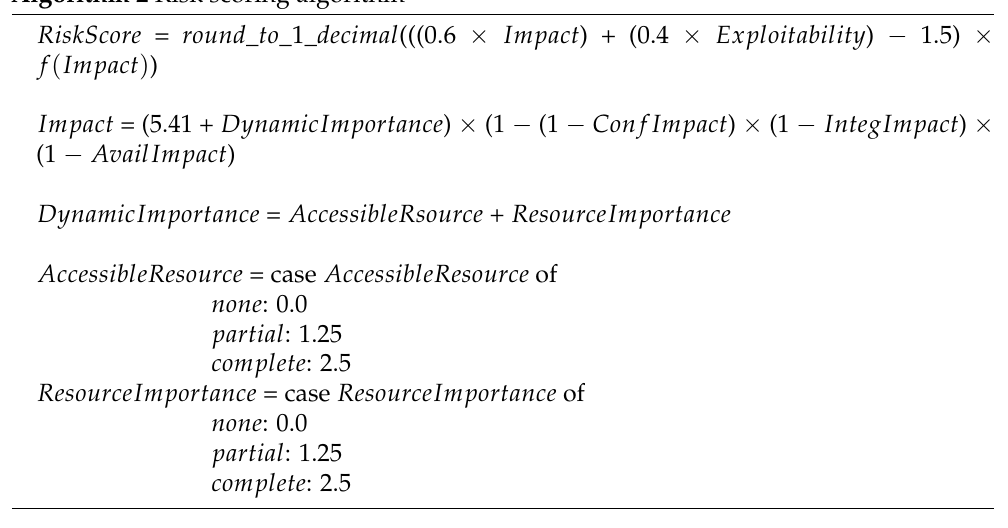
Algorithm 2 Risk scoring